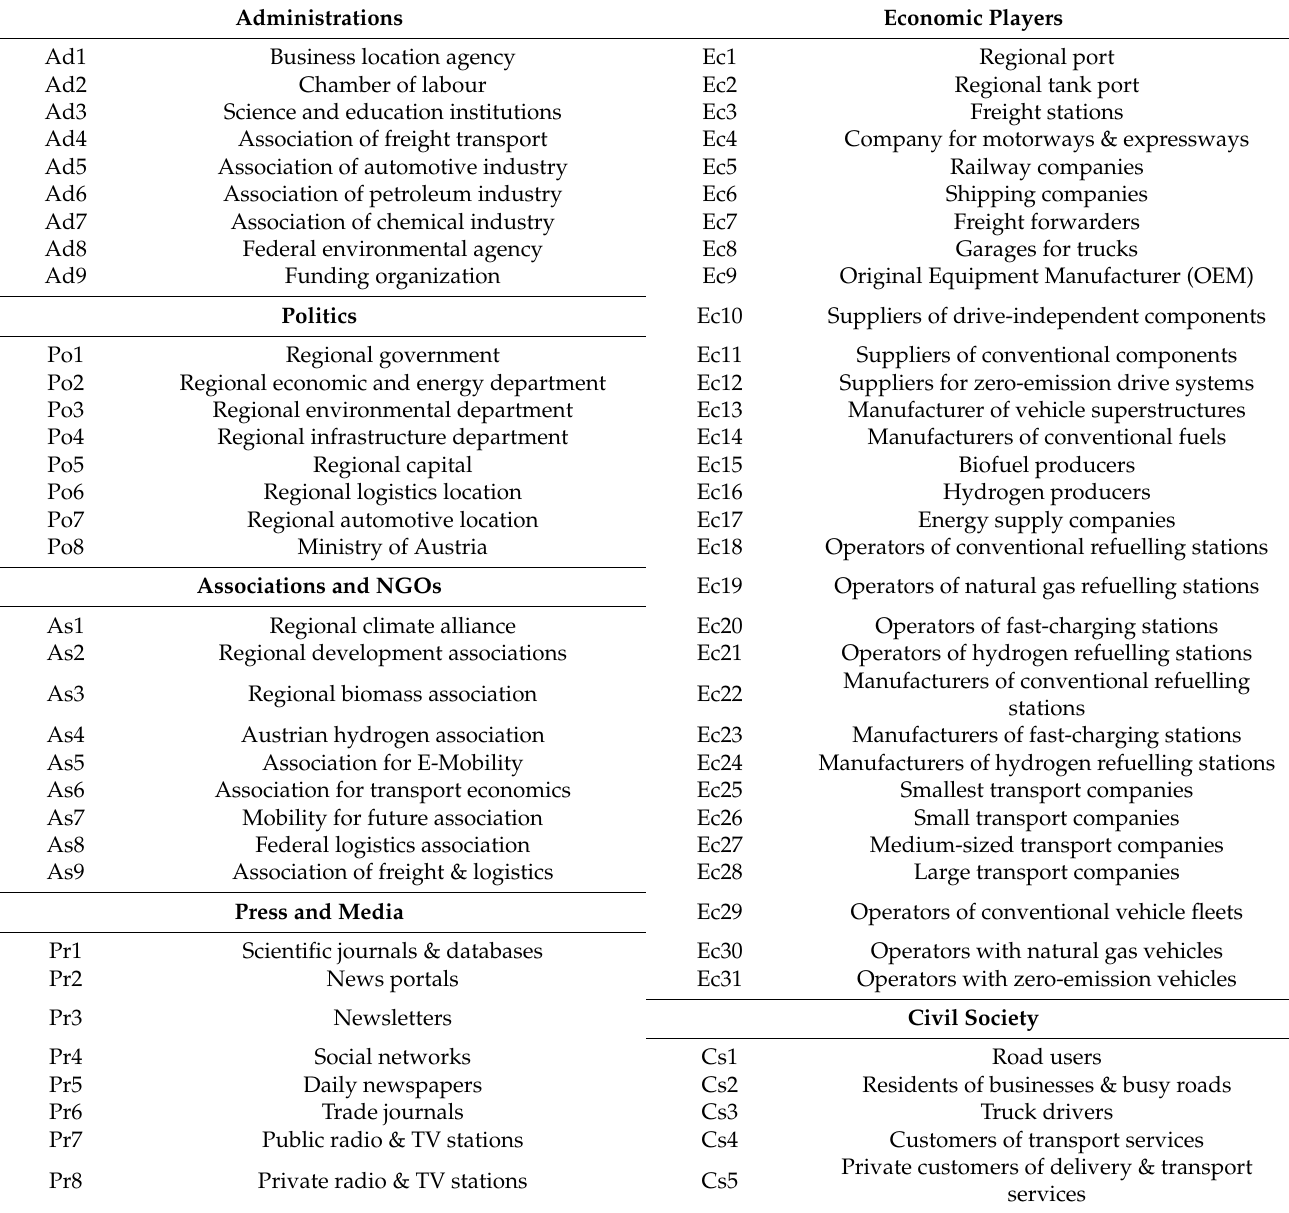
Table 1. Number and name of stakeholders per dimension towards zero-emission heavy-duty